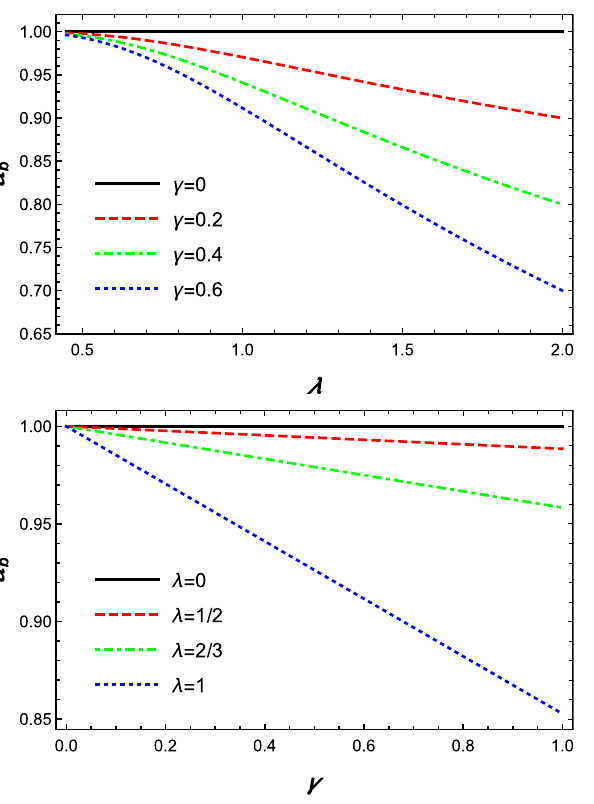
Fig. 10 α b for different value λ and γ in the vacuum